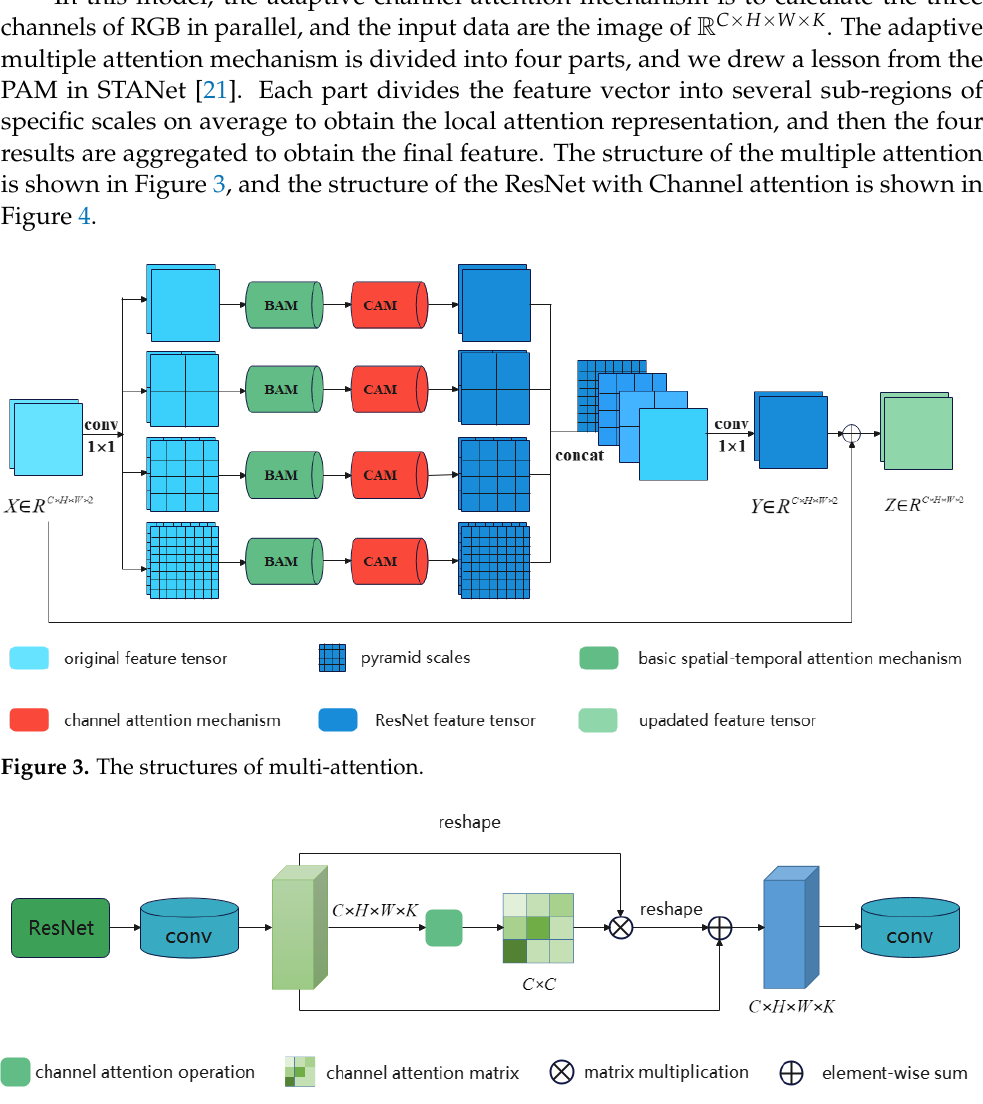
Figure 4. The structures of ResNet with Channel